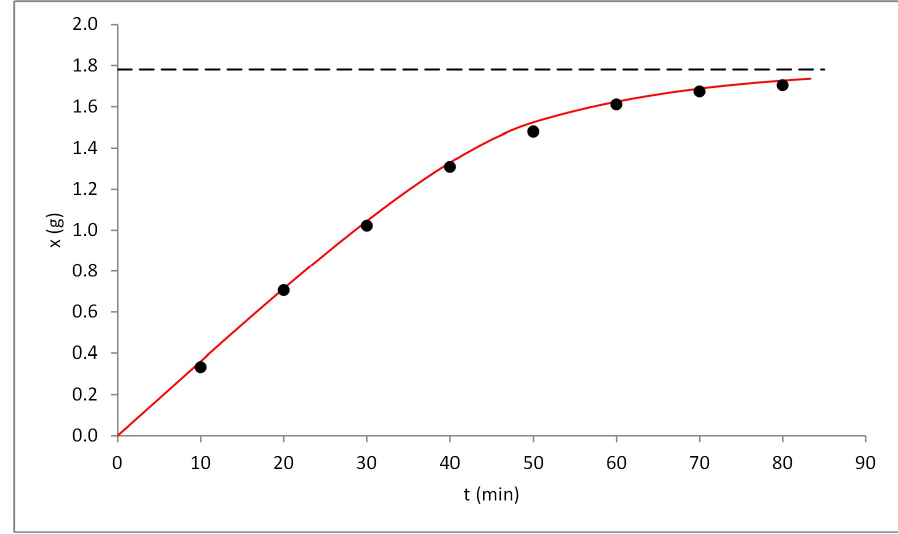
Figure 6. The comparison of the yield of ursolic acid obtained during extraction in a 500-mL vessel (black dots) and the extraction curve predicted using Broken plus Intact Cell (BIC) model (red line).